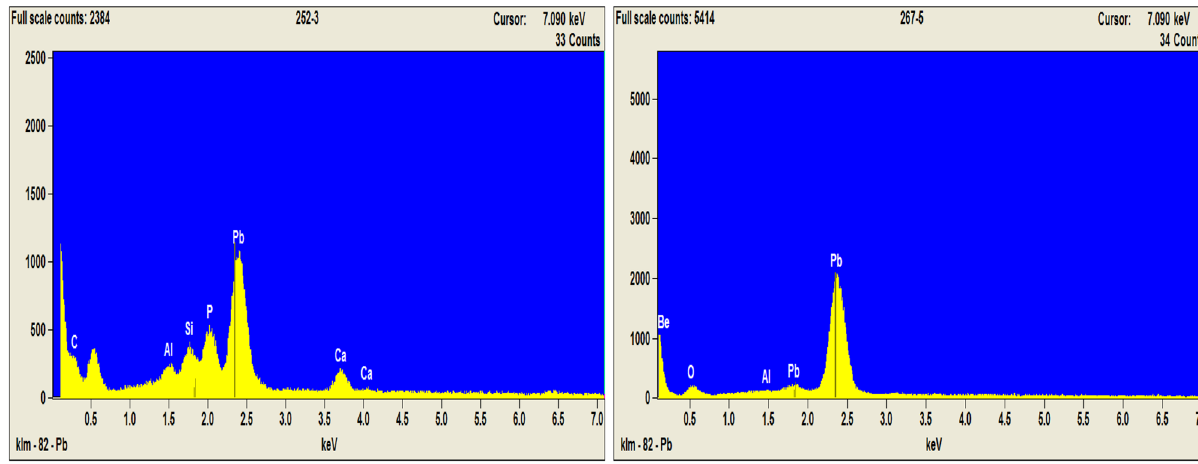
Figure 7. EDS patterns of Pb solids in selected amendment treated (SMC, left) and untreated (control, right) mining wastes during the 8–10 year sampling period post